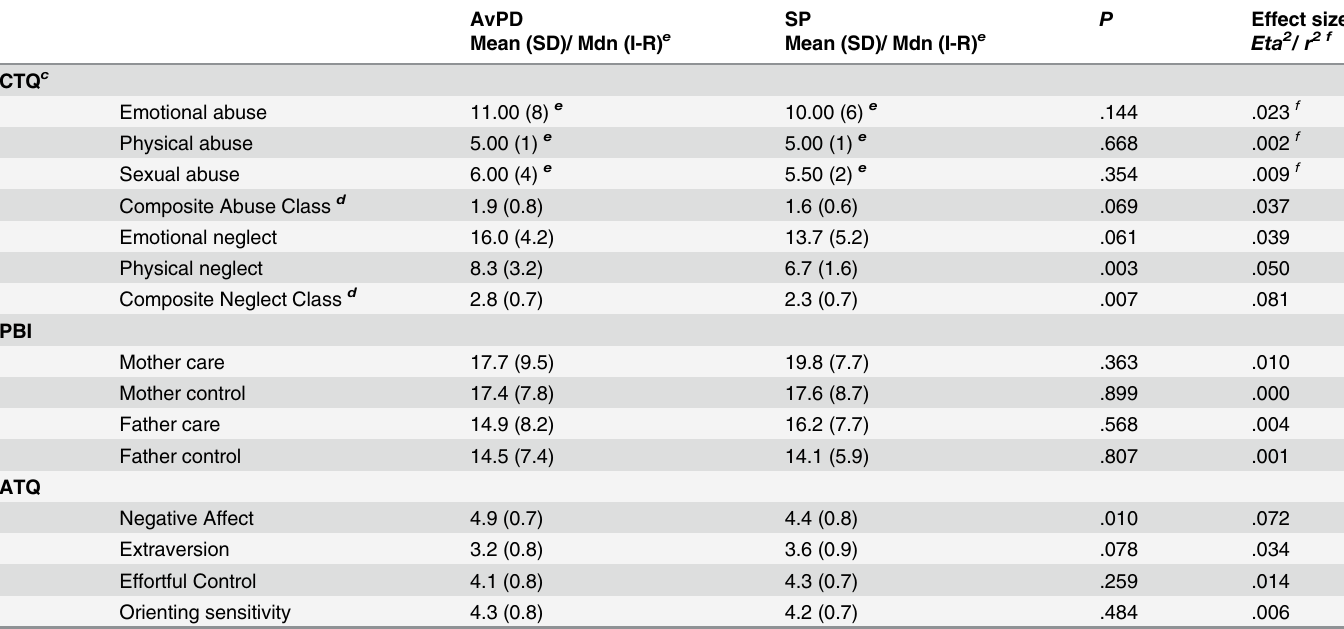
Table 3. Clinical Characteristics of Patients with AvPD a ( n = 71) and SP b ( n = 20). AvPD SP P Effect size Mean (SD)/ Mdn (I-R) e Mean (SD)/ Mdn (I-R)